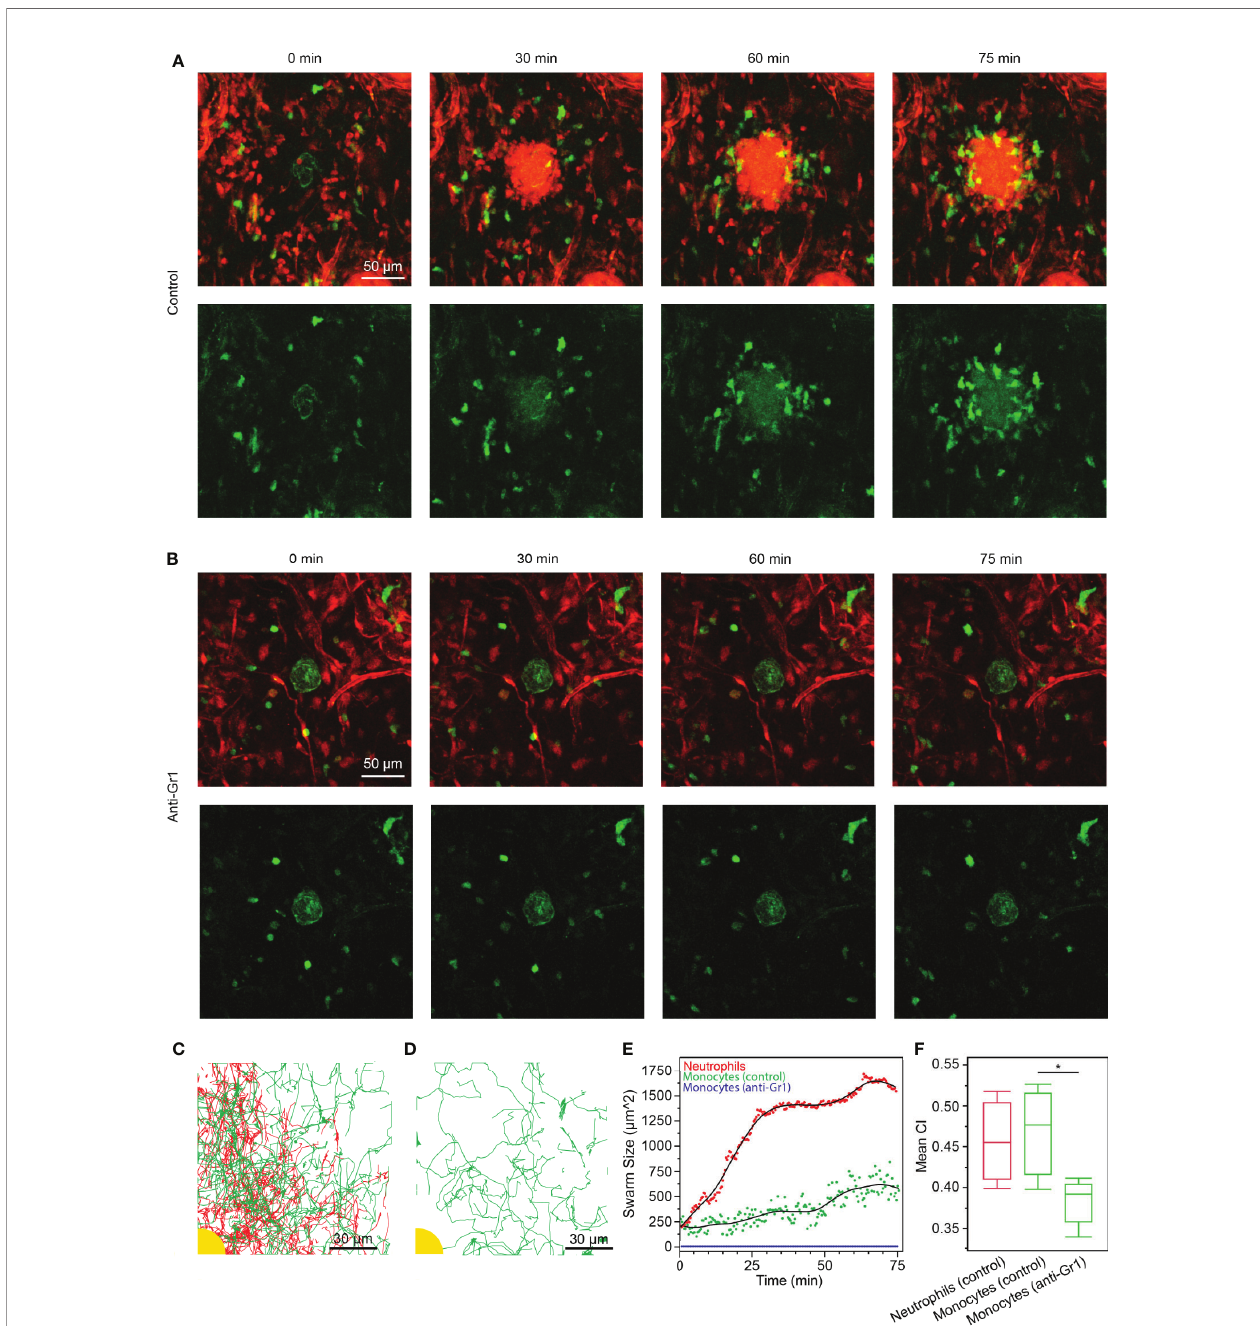
FIGURE 4 | (A, B) Time-lapse sequences of endogenous neutrophil and macrophage/monocyte dynamics in DsRed +/- Cx3cr1 gfp/gfp Tyr c-2J/c-2J mice (macrophages/ monocytes in green, stroma and neutrophils in red). (scale bars: 50 µm) (A) As previously shown (1), small red cells (neutrophils) cluster within 30 min around the local site of laser-induced tissue injury (green auto fl uorescence in the image center). Cx3cr1-GFP macrophages/monocytes assemble around neutrophil cluster with a time delay. Representative experiment of n=3. (B) Anti-Gr1 mediated treatment of mice depleted neutrophils from mouse tissue (macrophages/monocytes in green, stroma in red), resulting in non-directional motility of Cx3cr1-GFP cells around the tissue lesion site. Representative experiment of n=2. (C) Tracks of neutrophils (red) and monocytes (green) as they accumulated around the site of injury (yellow). (scale bar: 30 µm) (D) Tracks of monocytes (green) when neutrophils were depleted with anti-Gr1. No accumulation was observed around the site of injury (yellow). (scale bar: 30 µm) (E) Neutrophil swarming occurred rapidly around the site of injury and leveled out after 30 min at 1400 ± 35 µm 2 . In the presence of swarming neutrophils, monocytes accumulated gradually over time, reaching 542 ± 114 µm 2 after 75 min. Conversely, no monocyte accumulation occurred when neutrophils were depleted. (F) The CI of monocytes was signi fi cantly higher in the control experiment than when neutrophils were depleted with anti-Gr1 (Statistical test: *p < 0.005). There was no signi fi cant difference between the CI of neutrophils and monocytes in the control experiment ( a =